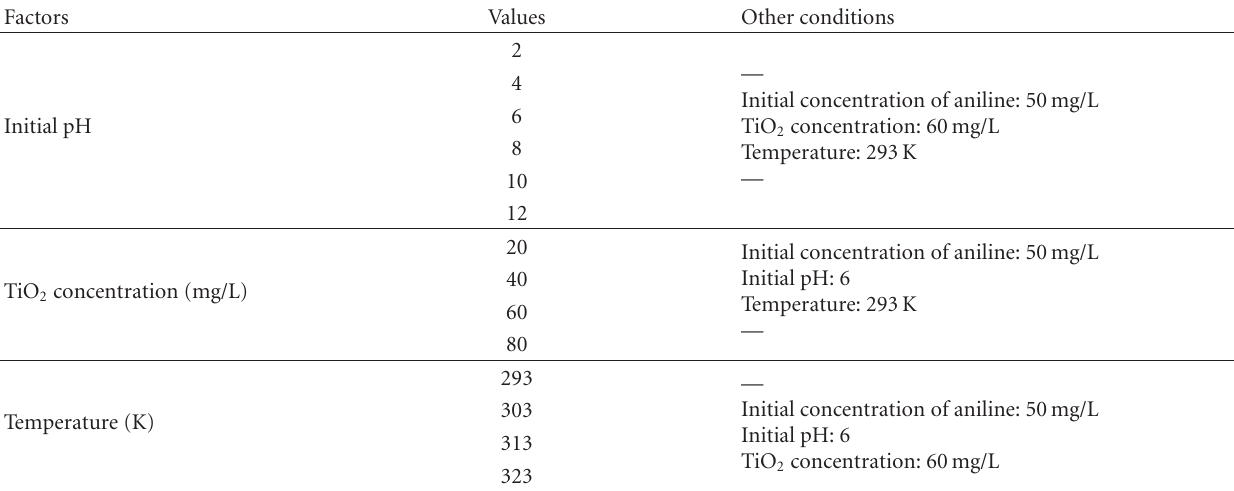
Table 1: Experimental design for photocatalytic degradation of